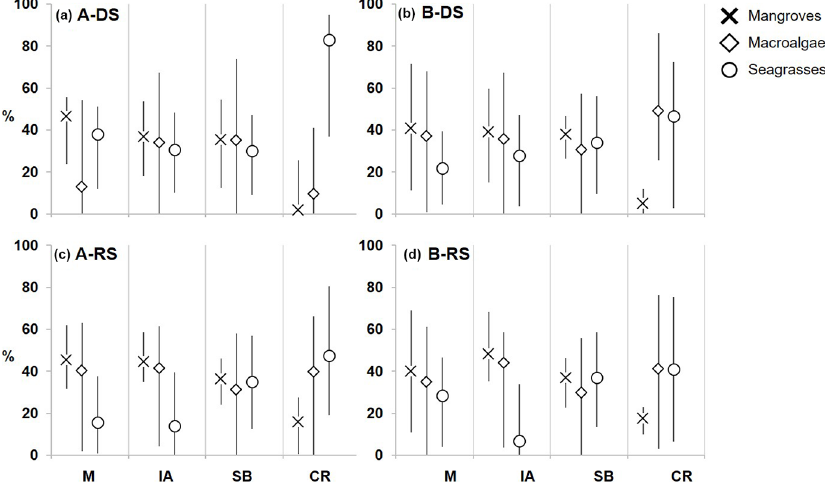
Figure 4. Organic matter source probability of contribution (mode ± 95th credibility interval) to SOM in the four sampling stations (man- grove forest, M; intertidal area, IA; seagrass bed, SB; coral reef, CR) along transects A and B in dry (DS) and rainy season (RS). Mangroves (cross), macroalgae (diamond) and seagrasses (circle).